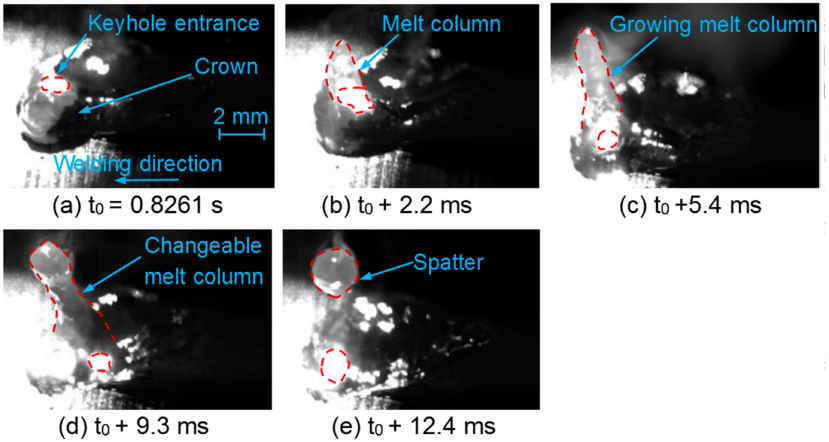
Figure 4. Images of the keyhole entrance and surface weld pool dynamics without a gas jet (p = 10 kW, v = 0.9 m/min, ∆ = − 5 mm, q = 10